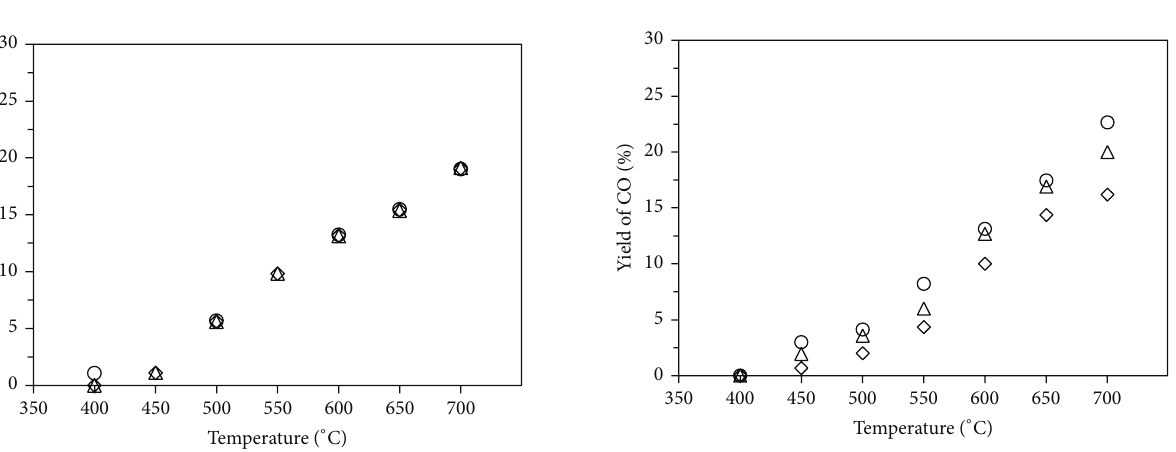
Figure 6: RWGS reaction at 1atm, 𝑃 GHSV = 176000 h −1 , and 50 mg of catalyst: Pt/C, 1wt%, where ⃝ = 1st cycle, △ = 2nd cycle, and ⬦ = 3rd cycle.